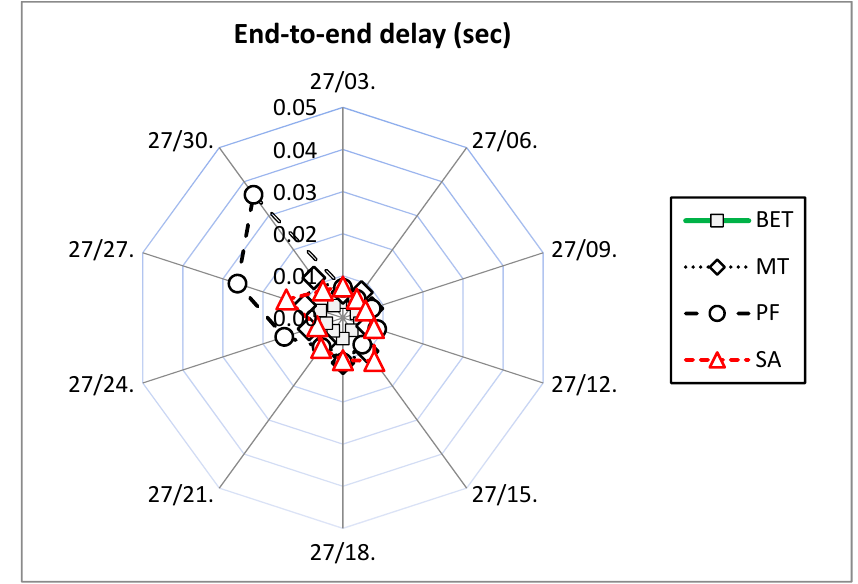
Figure 13. Average packet end-to-end delay for video cell-edge users in mixed traffic.